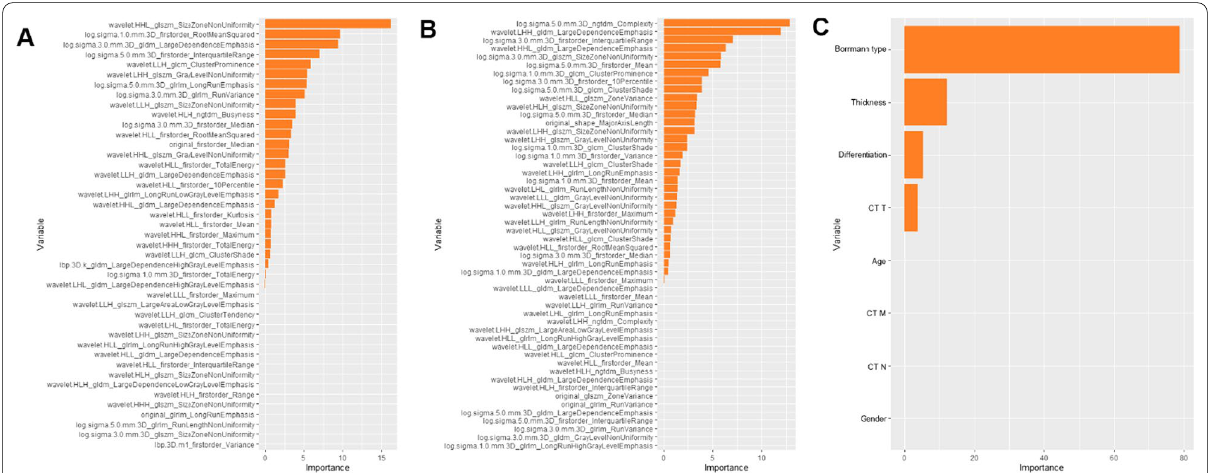
Fig. 2 The ranked importance of GBDT selected features for each independent model. A Arterial-phase radiomics features. B The venous-phase radiomics features. C The clinical